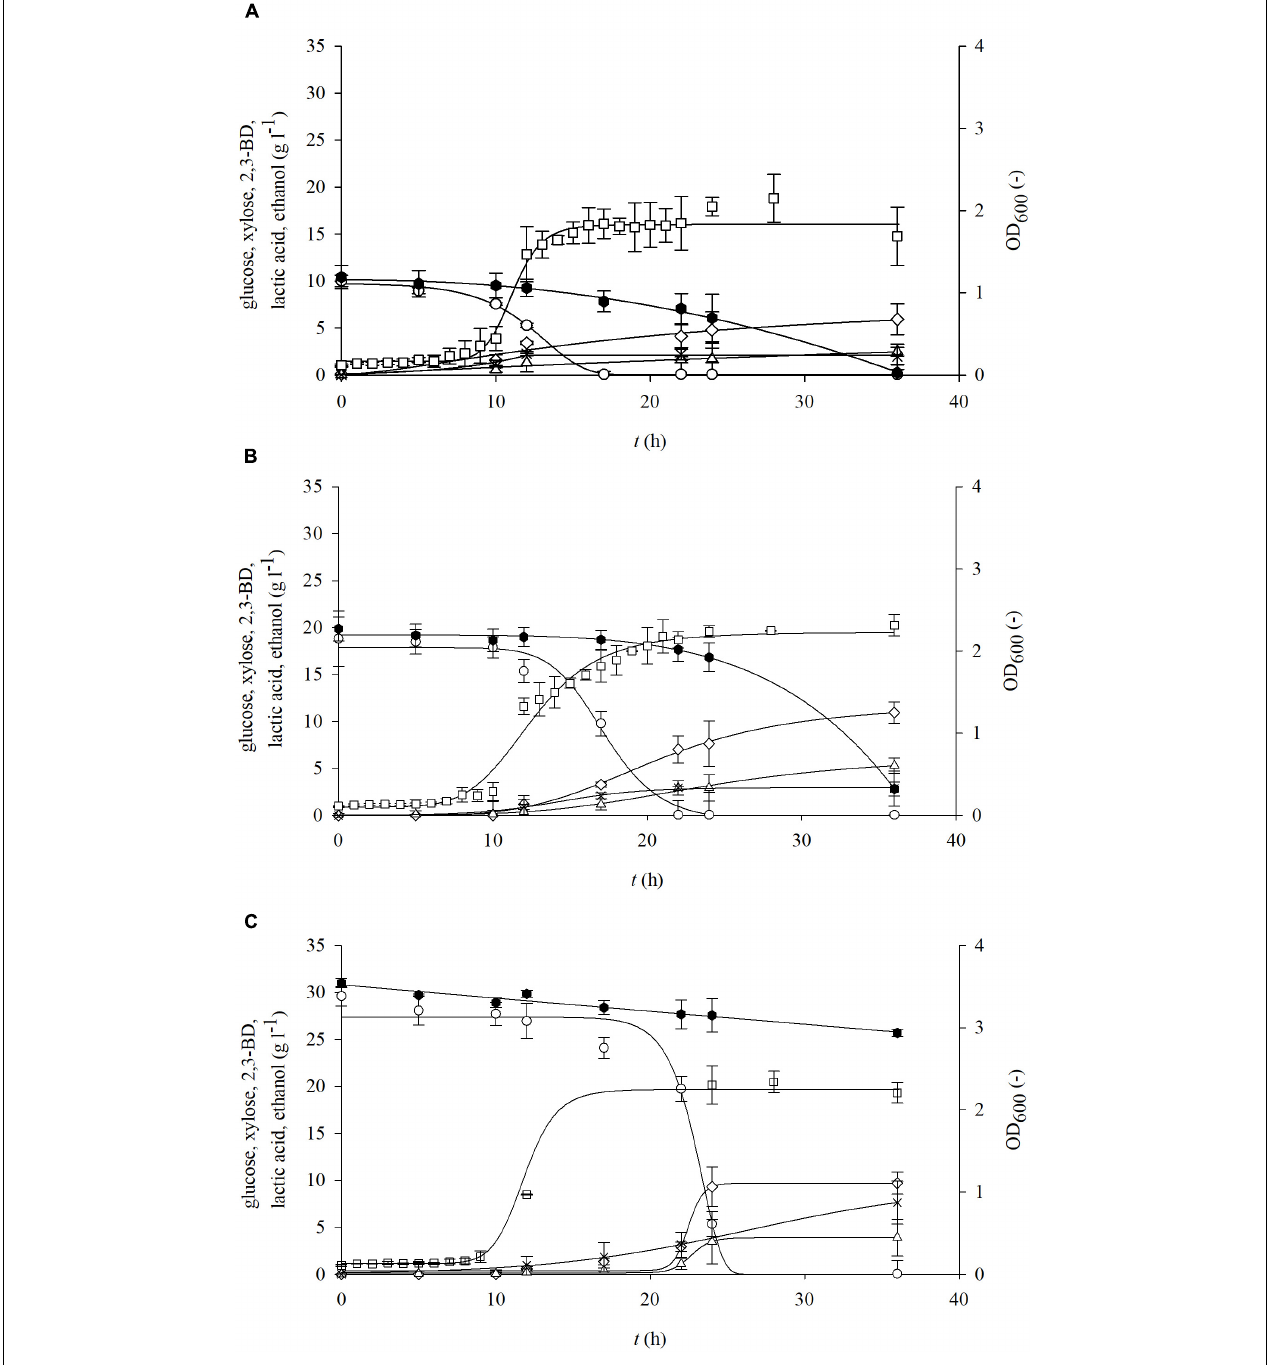
FIGURE 3 | Changes in optical density (OD 600 , (cid:3) ) and concentration of glucose ( (cid:13) ), xylose ( ), 2,3-BD ( (cid:5) ), lactate ( (cid:78) ), and ethanol ( (cid:52) ) during cultivation of bacterium P. polymyxa DSM 742 in media with different initial glucose and xylose concentrations [ (A) 10 g l − 1 glucose and 10 g l − 1 xylose; (B) 20 g l − 1 glucose and 20 g l − 1 xylose; (C) 30 g l − 1 glucose and 30 g l − 1